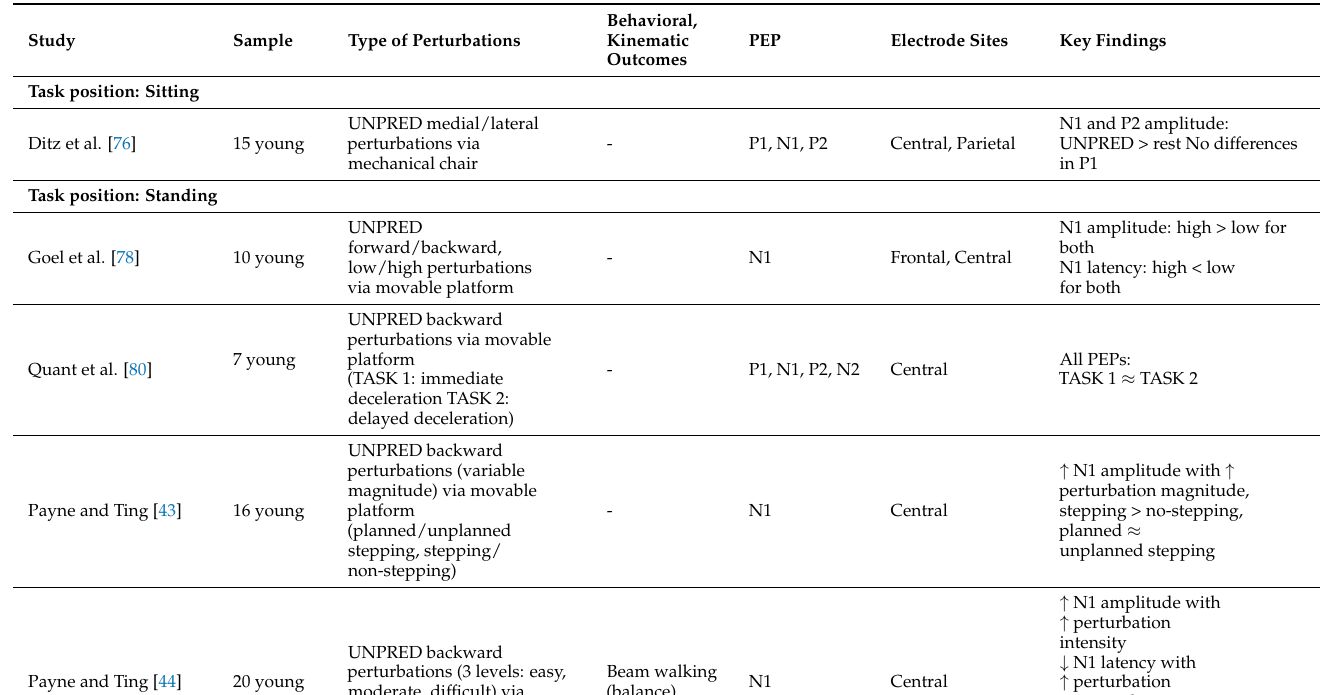
Table 2. Perturbation-evoked potentials (PEPs) recorded via electroencephalography (EEG) during novel unpredictable (UNPRED) mechanical perturbations